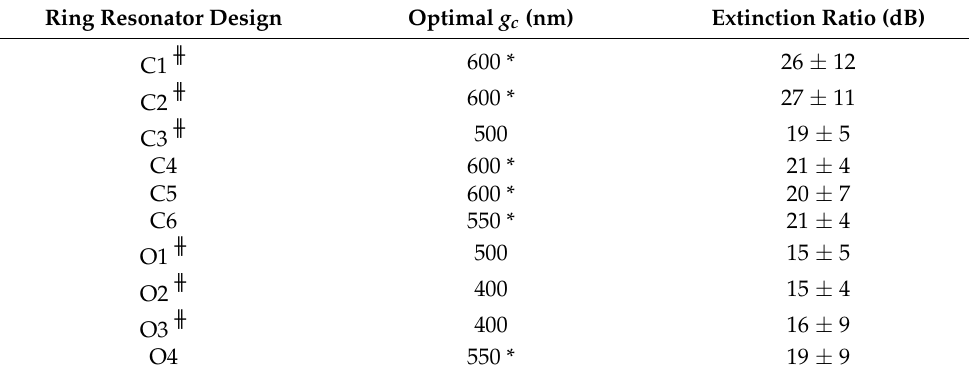
╫ Fishbone SWG designs.